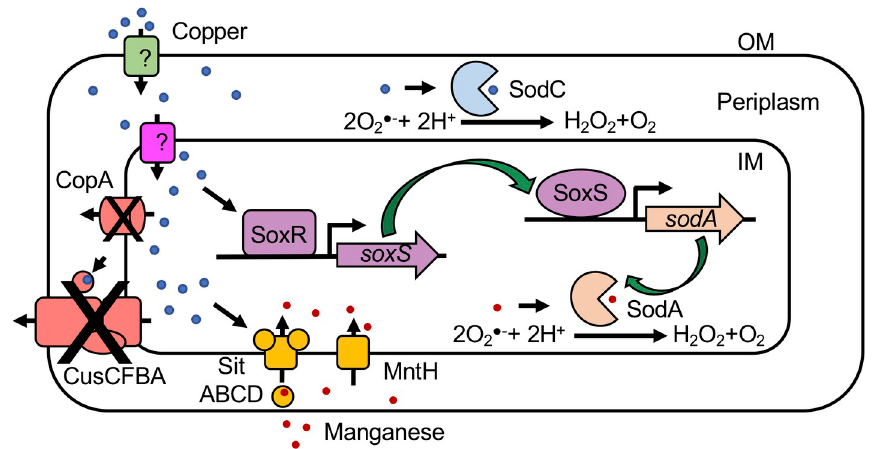
Fig 9. Working model of copper-dependent protection of UPEC from superoxide. High levels of copper in the environment results in increased cellular copper content. Copper stress increases the expression of copper efflux and manganese import genes. Accumulation of copper and manganese is exaggerated in copper-efflux defective mutants. Activation of SoxR culminates in increased SodA activity via induction of SoxS-dependent transcription of sodA . Copper stress also enhances the activity of SodC. Collectively, these copper-dependent changes impart protection from killing by superoxide. IM, inner membrane; and OM, outer membrane.